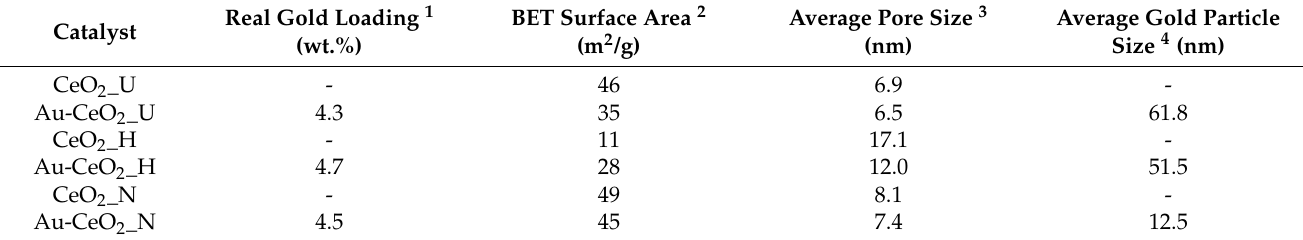
Table 1. Characteristics of catalysts prepared with the use of different co-precipitation agents: urea (catalysts labelled as CeO 2 _U and Au-CeO 2 _U), HMTA (catalysts labelled as CeO 2 _H and Au-CeO 2 _H) and NaOH (catalysts labelled as CeO 2 _N and Au-CeO 2 _N). Catalyst